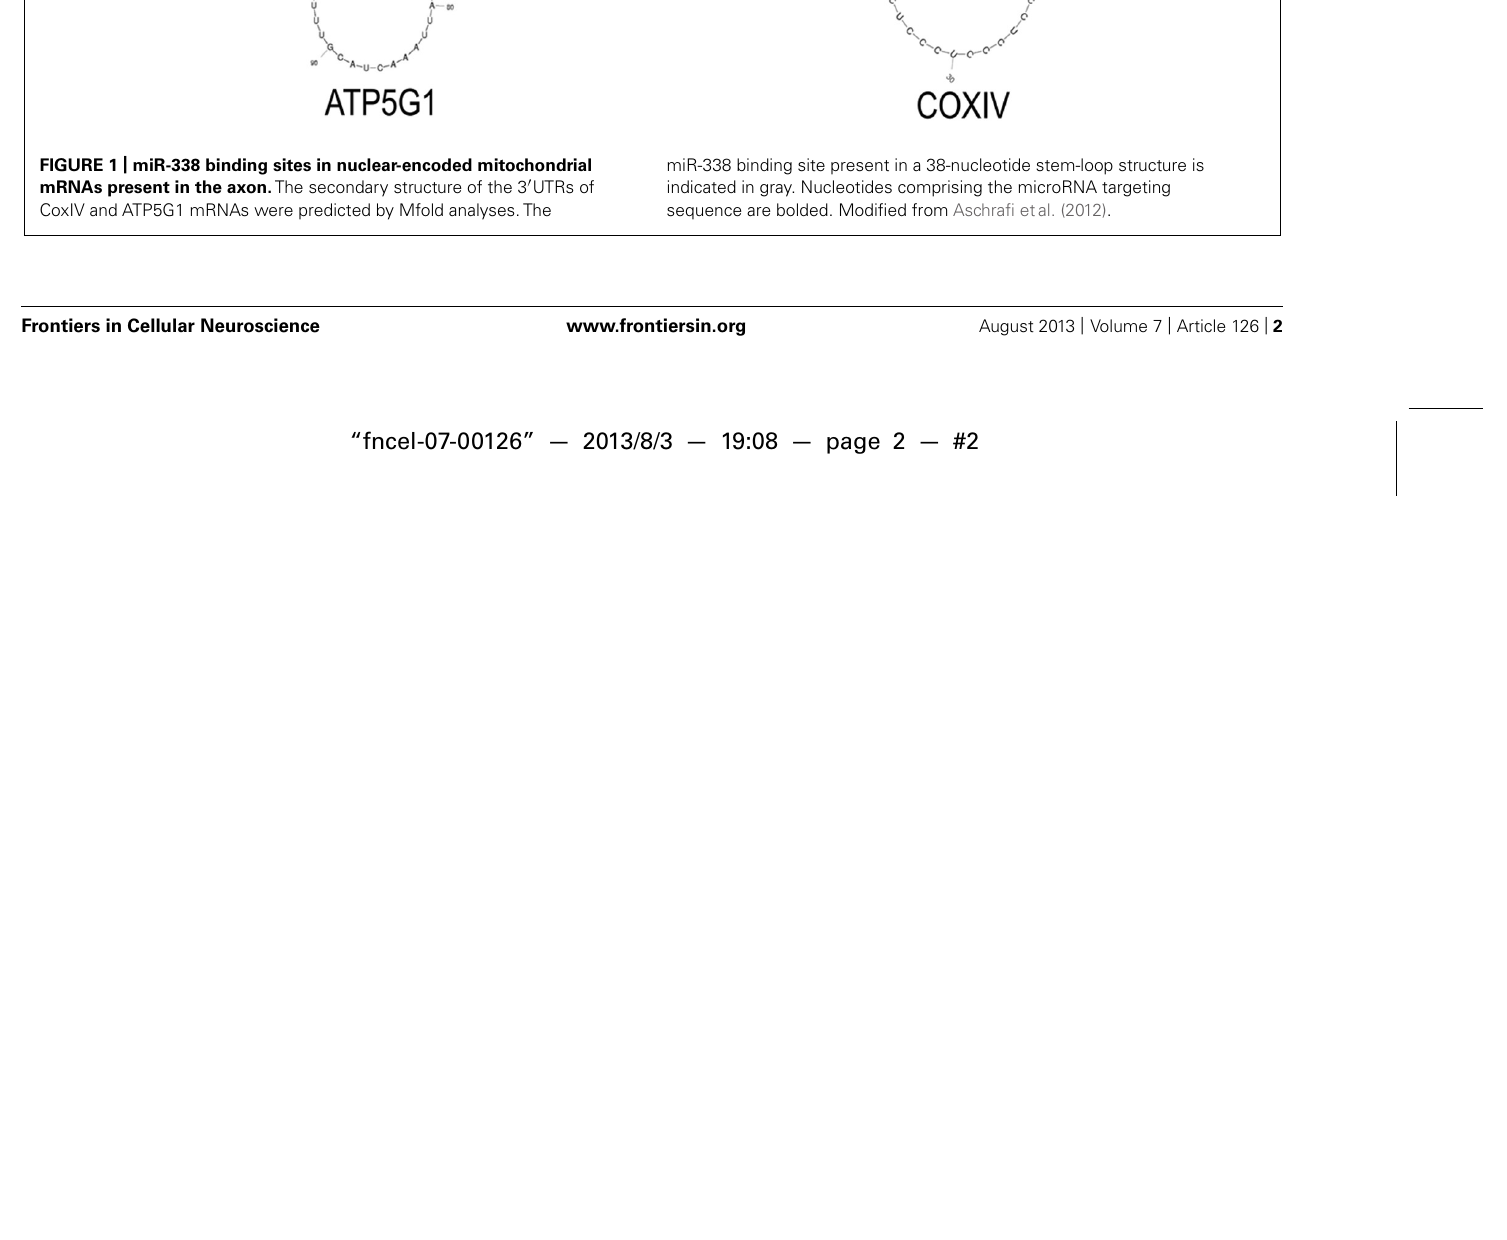
miR-338 binding site present in a 38-nucleotide stem-loop structure is indicated in gray. Nucleotides comprising the microRNA targeting sequence are bolded. Modified from Aschrafi etal.